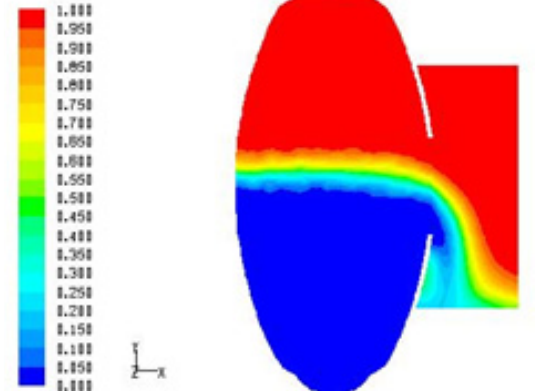
Fig. 3-4. Water level just under the upper edge of the chamber, the rotating flow inside is transformed into axial outer flow; the gravity influence is visible yet.